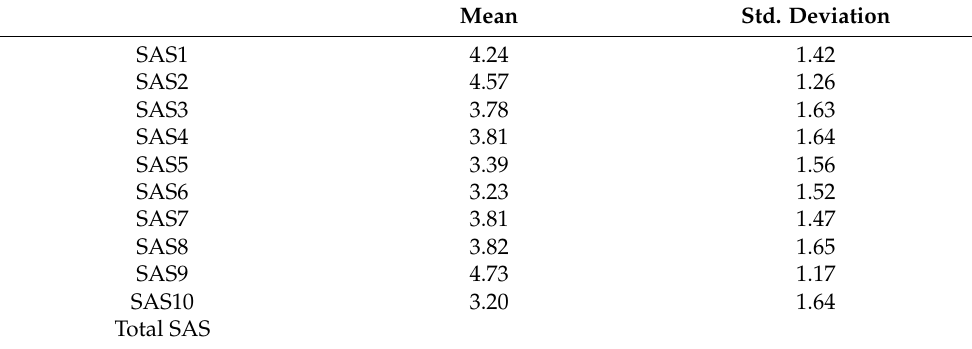
Table 8. Mean and standard deviation of